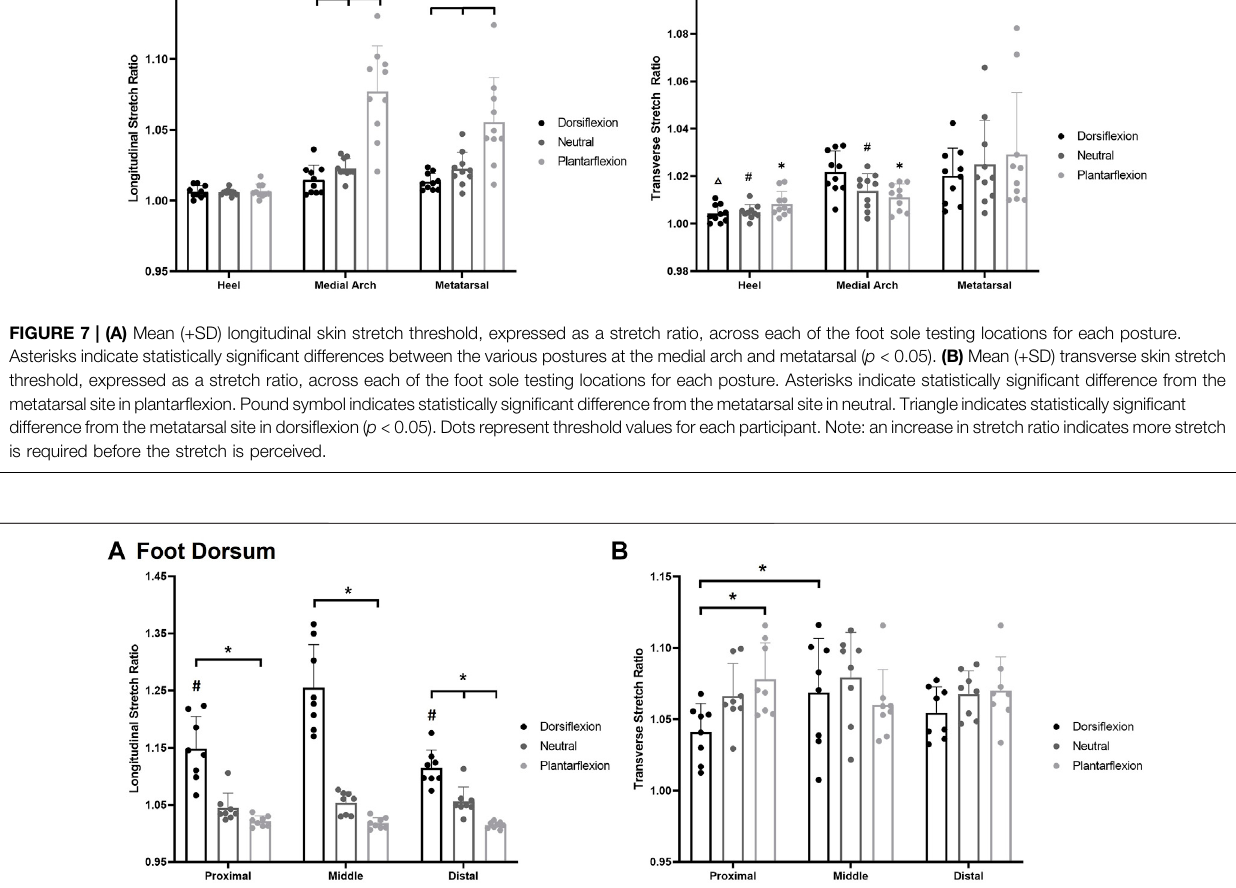
FIGURE 8 | Mean (+SD) longitudinal skin stretch threshold, expressed as a stretch ratio, across each of the foot dorsum testing locations for each posture (A) . Asterisks indicate statistically signi fi cant differences between the various postures ( p < 0.05). Pound symbol indicates statistically signi fi cant difference from the middle site inthedorsi fl exionposture.Mean(+SD)transverseskin stretch threshold, expressed asastretchratio,acrosseach ofthe footsole testing locations foreach posture (B) .Asterisksindicatestatisticallysigni fi cantdifferencefromtheproximalsiteinthedorsi fl exionposture.Dotsrepresentthreshold valuesforeachparticipant.Note: an increase in stretch ratio indicates more stretch is required before the stretch is